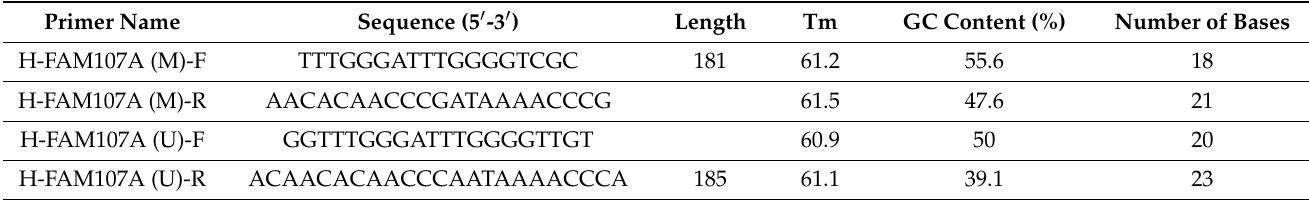
Table 2. Primers for MSP